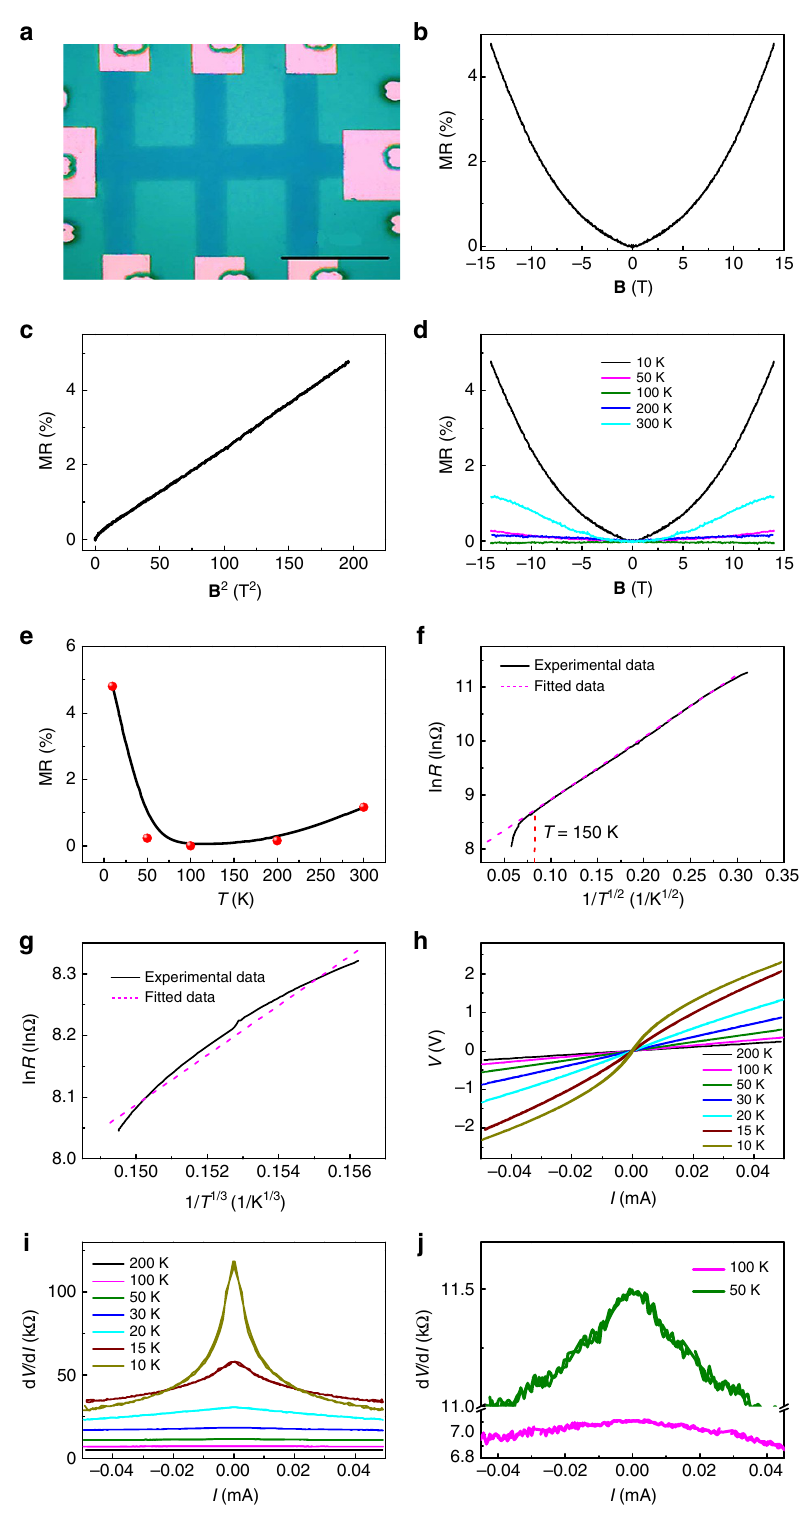
Figure 2 | MR and I-V characterization of graphene on SiC. ( a ) Typical optical image of the graphene Hall bar device. Scale bar, 40 m m. ( b ) MR curve measured at 10K with an in-plane magnetic field. ( c ) MR for an in-plane magnetic field as a function of B 2 . ( d ) Temperature dependence of MR curves measured with an in-plane magnetic field along the current direction. ( e ) MR ratio for an in-plane magnetic field as a function of temperature. ( f ) Resistance R as a function of temperature T in the low temperature range 10–150K. The low-temperature behaviour of ln( R ) can be fitted as a straight line with respect to the variable 1/ T 1/2 , indicating a 1D channel behaviour in the VRH model. ( g ) At high temperatures, ln( R ) shows a clearly different behaviour and can be fitted better with the function 1/ T 1/3 up to 300K, suggesting 2D VRH transport. I–V curves ( h ) and the corresponding d V /d I curves ( i , j ) measured at a variety of